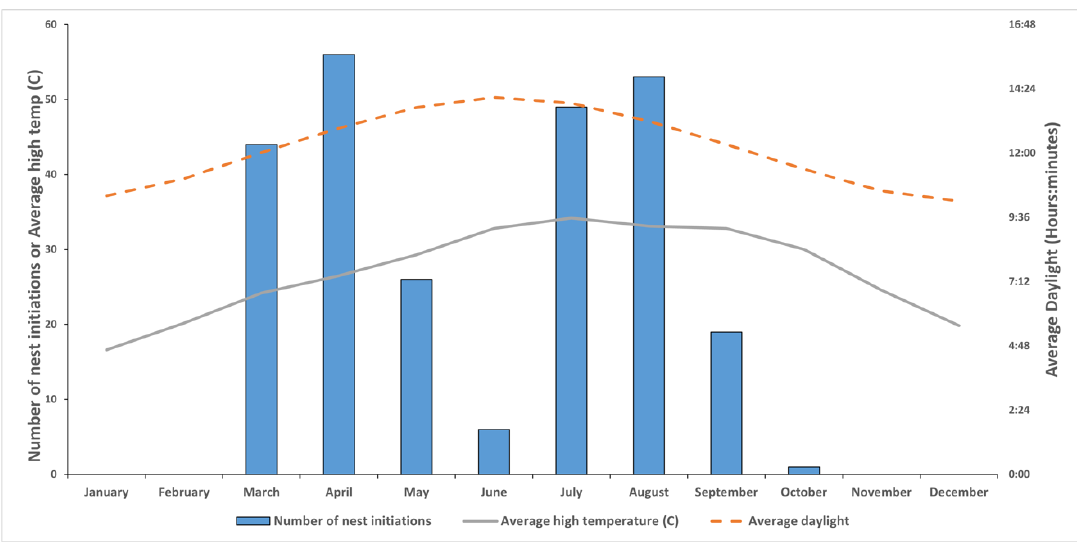
Figure 2. Number of polistine nest initiations per month (blue bars), average monthly high temper- ature (°C) (solid line), and average daylight per month (hrs:mins) (dotted line) during 2016 in Baton Rouge.